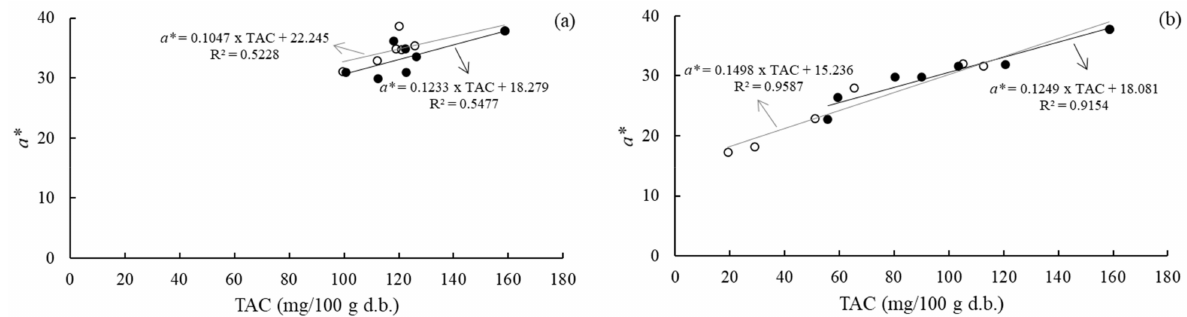
Figure 4. Relationship between the total anthocyanin content (TAC) and a* chromatic parameter of strawberry leather during storage at 22.5% RH ( a ) and 52.3% RH ( b ), with no illumination ( • ) and with illumination ( (cid:35)